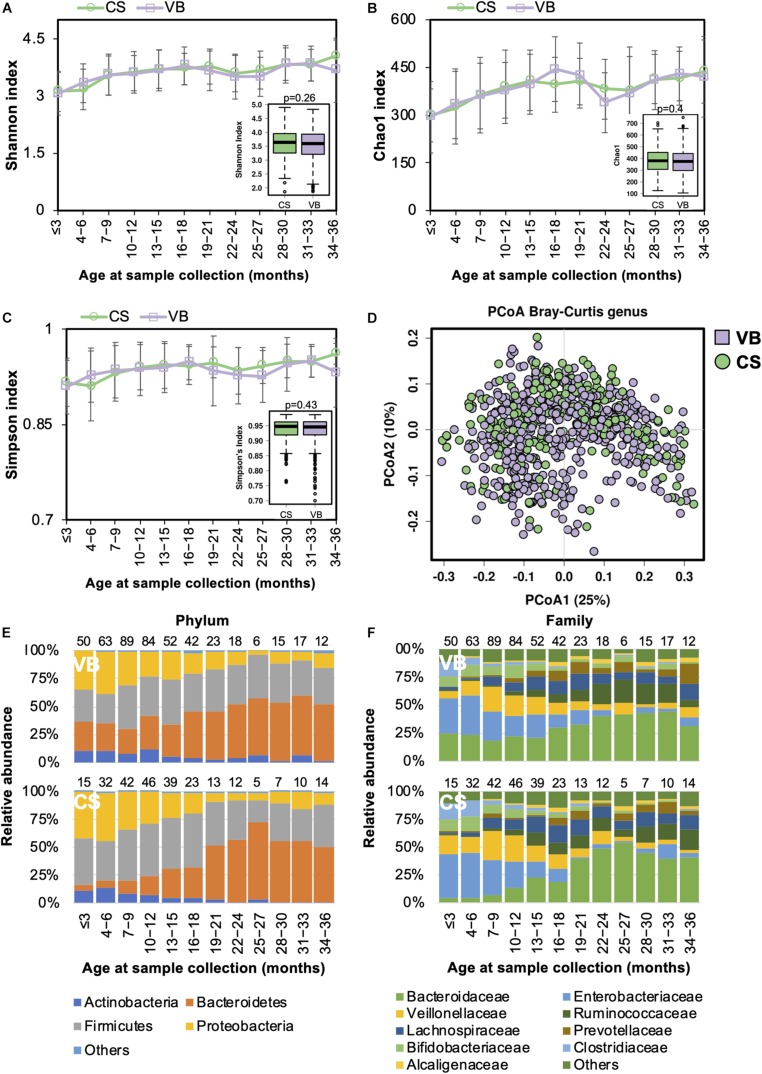
Fecal microbiota diversity and composition for 729 children according to delivery mode. Alpha diversity, which was calculated by (A) Shannon index, (B) Chao1, or (C) Simpson’s index, showed no significant difference between the two birth modes. (D) PCoA showed no clear separation between samples based on the two birth modes. Birth-mode-stratified taxa summary composition of bacterial microbiota at the (E) phylum and (F) family levels. Number of children per age group is provided above bars.